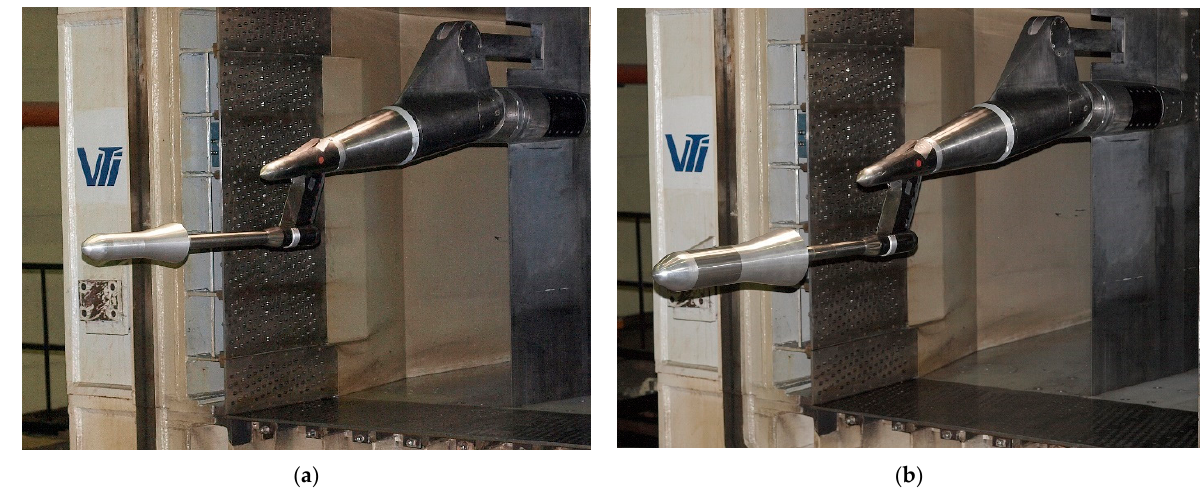
Figure 14. HB-2 models on the articulated 10 ° bent sting in the T-38 wind tunnel: ( a ) 75 mm diameter [55]; ( b ) 100 mm diameter [47].